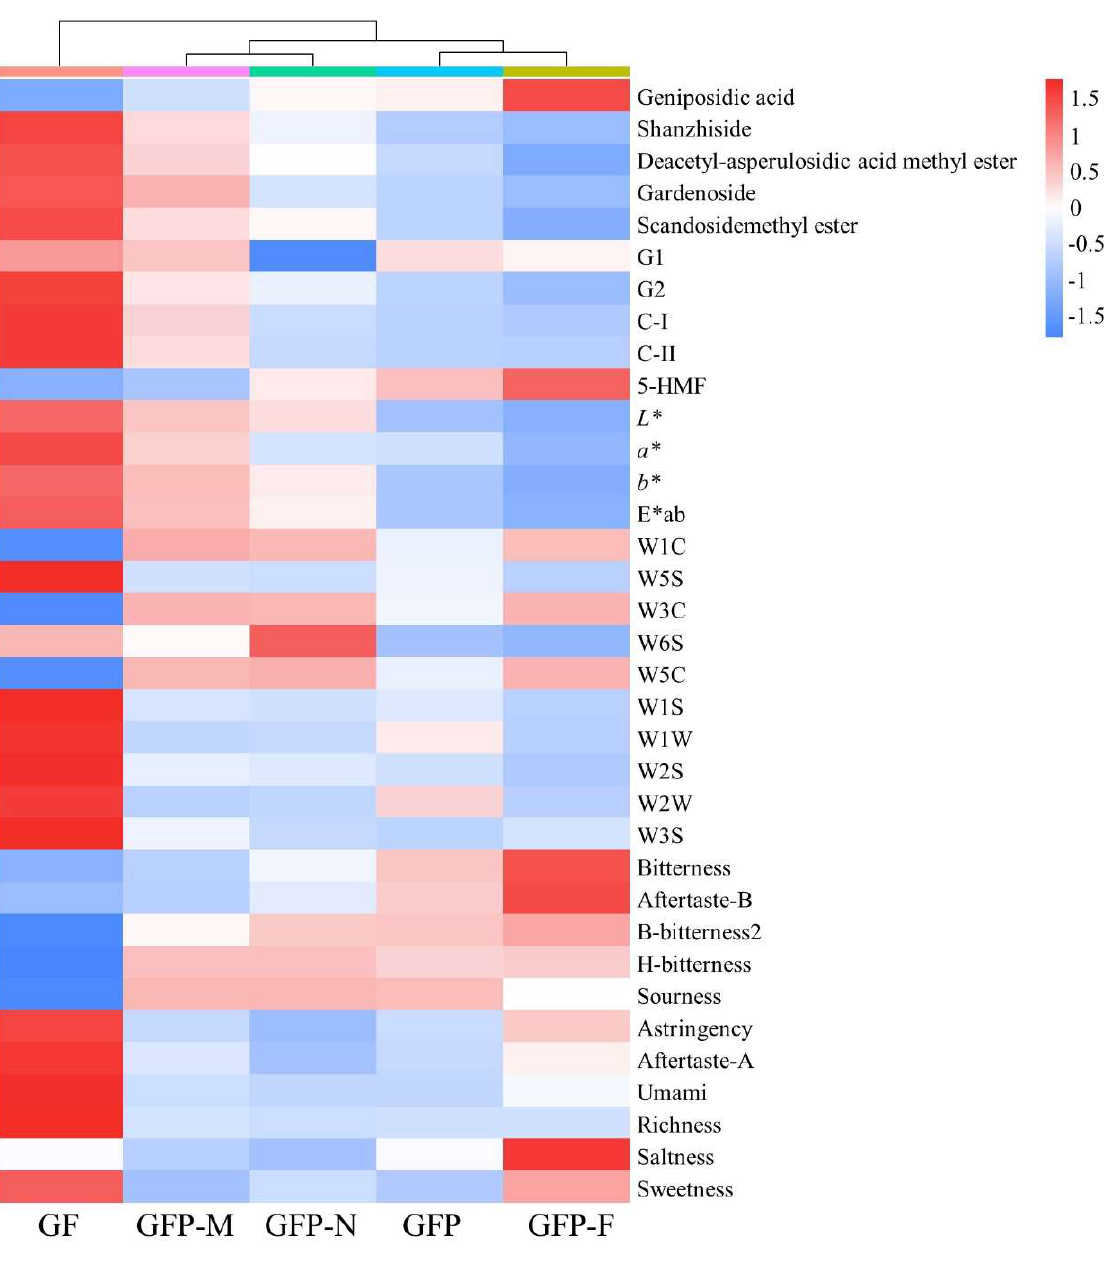
Figure 7. Cluster heatmap for estimating the processing stage of GFP. The scale bar of the heatmap represents Z-score normalized.